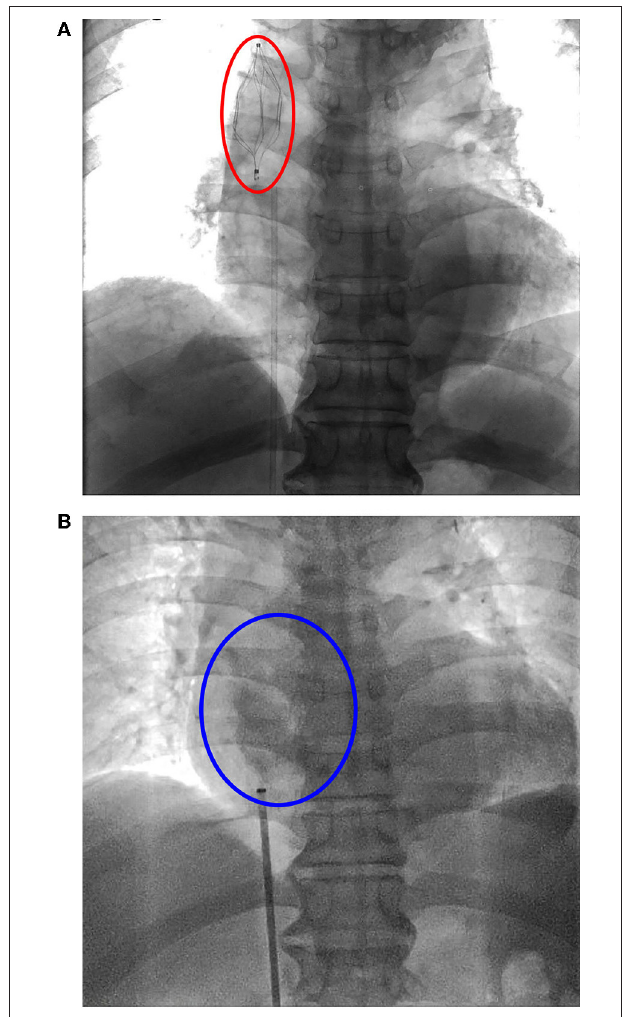
FIGURE 1 | (A) Superior vena cava filter (SVCF) implantation. Vena cava filter (red oval) was on the position. (B) Superior vena cava filter removal. There was no spillover of contrast agent (blue